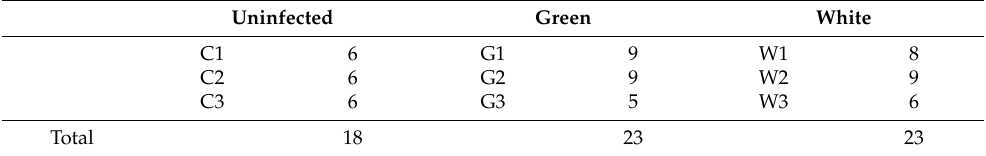
Table 3. Number of electronic nose measurements of the samples. C1–C3 are uninfected (control) samples, G1–G3 represent samples with green and W1–W3 samples with white fungi